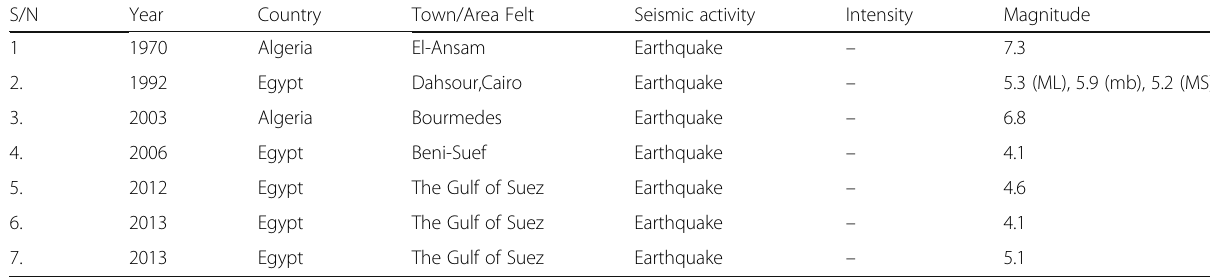
Table 2 Seismic occurrences, location, year, magnitude and intensity in North Africa S/N